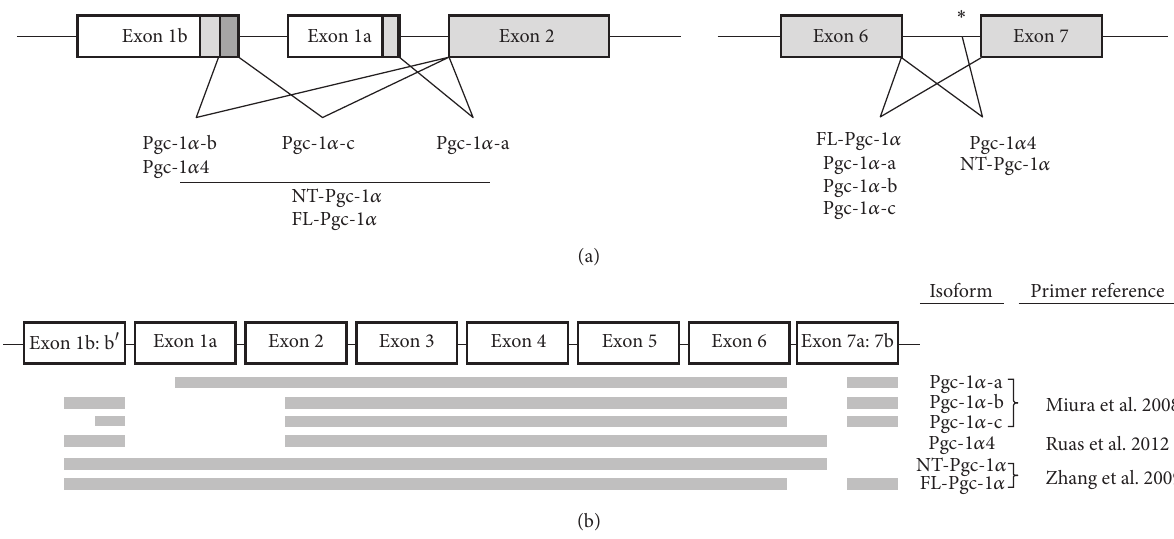
Figure 2: (a) Schematic structures of the 5 󸀠 and 3 󸀠 regions of Pgc-1 𝛼 are shown for each isoform. The 5 󸀠 schematic was slightly adapted from Miura et al. 2008. The proximal (exon 1a) or alternate (exon 1b) promoters can be spliced to exon 2. Within exon 1b, upstream (exon 1b) or downstream (exon 1b 󸀠 ) splicing to exon 2 can occur. Splicing also occurs between exons 6 and 7 near the 3 󸀠 end of the gene. Exon 6 can be spliced directly to exon 7, at two separate regions, 7a or 7b. Alternatively, exon 6 can be spliced to the intronic region preceding exon 7 to result in a truncated form of Pgc-1 𝛼 . Total NT-Pgc-1 𝛼 , FL-Pgc-1 𝛼 , and total Pgc-1 𝛼 all contain exons 1b:1b 󸀠 , 1a, and 2 as indicated. Total Pgc-1 𝛼 contains both exons 6 and 7, as indicated. (b) Schematic representation of the start and stop of each Pgc-1 𝛼 isoform is shown. Primer pairs have previously been designed and published, and the corresponding reference for each pair is indicated. ∗ is the alternative splice site between exons 6 and